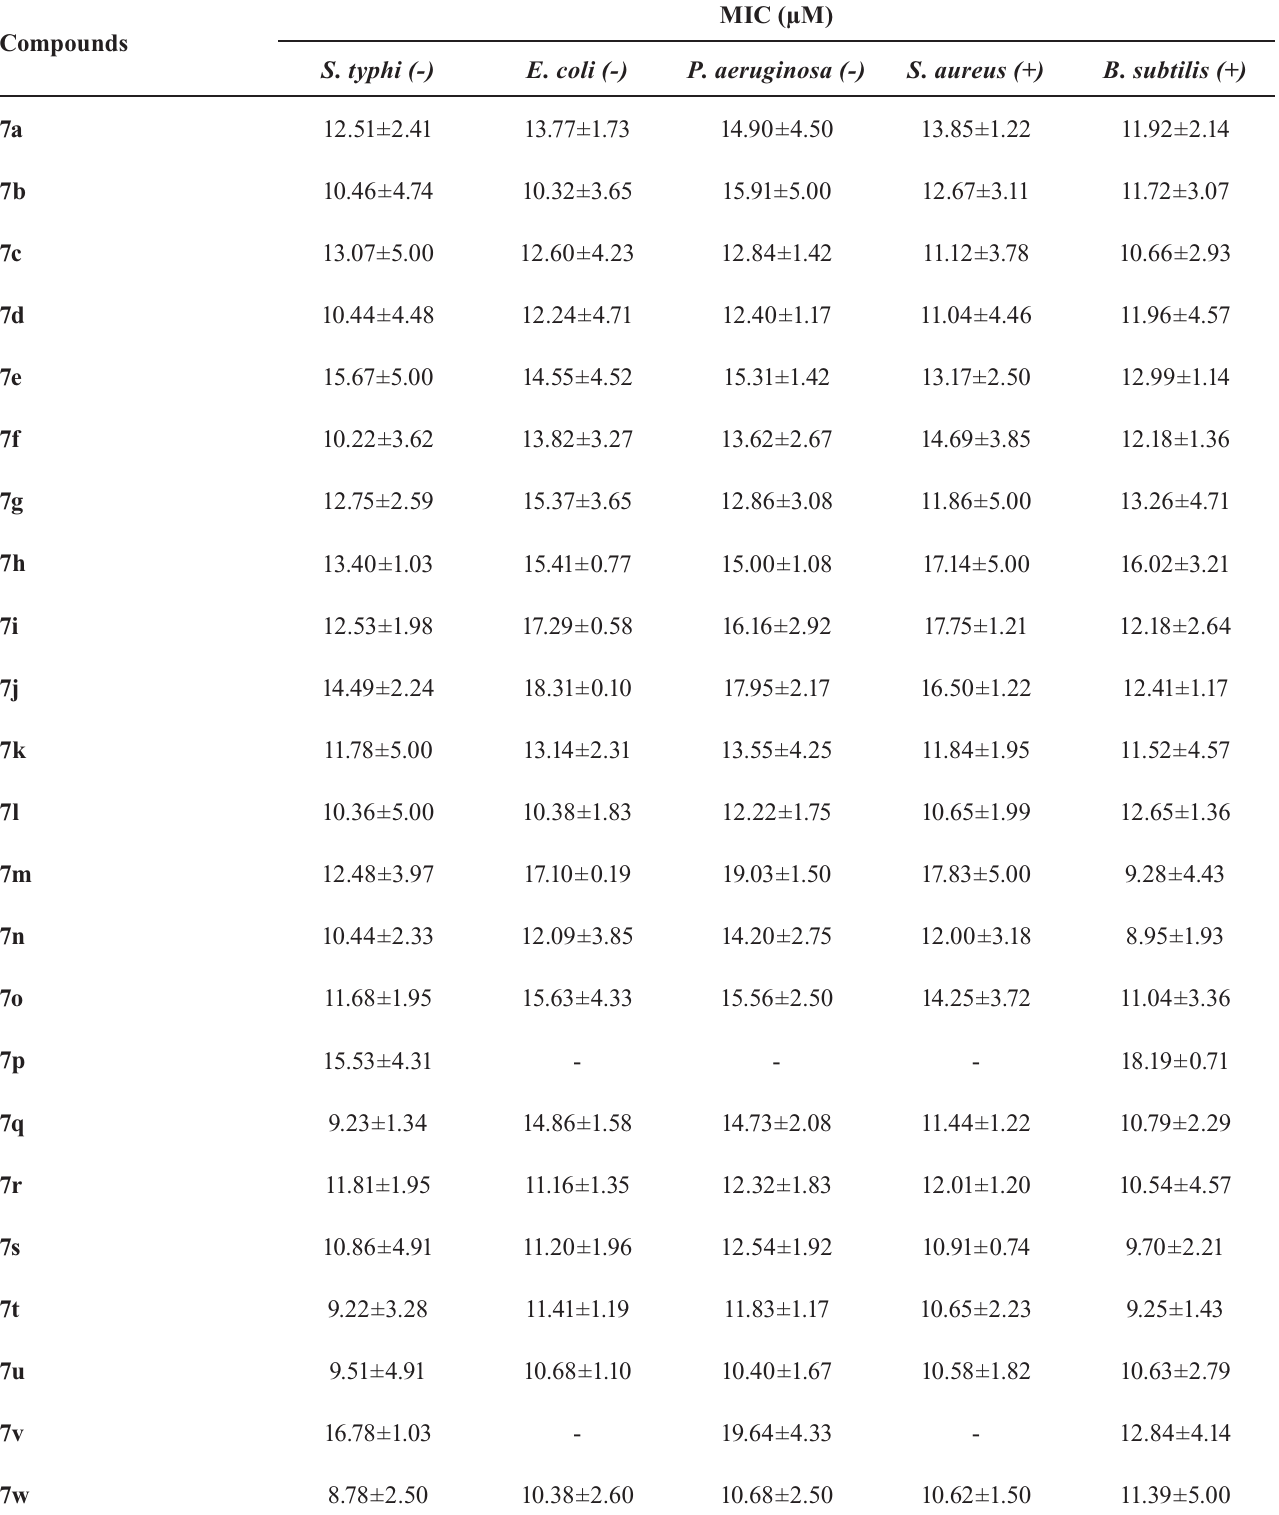
TABLE III - The MIC of antibacterial activity of synthesized compounds